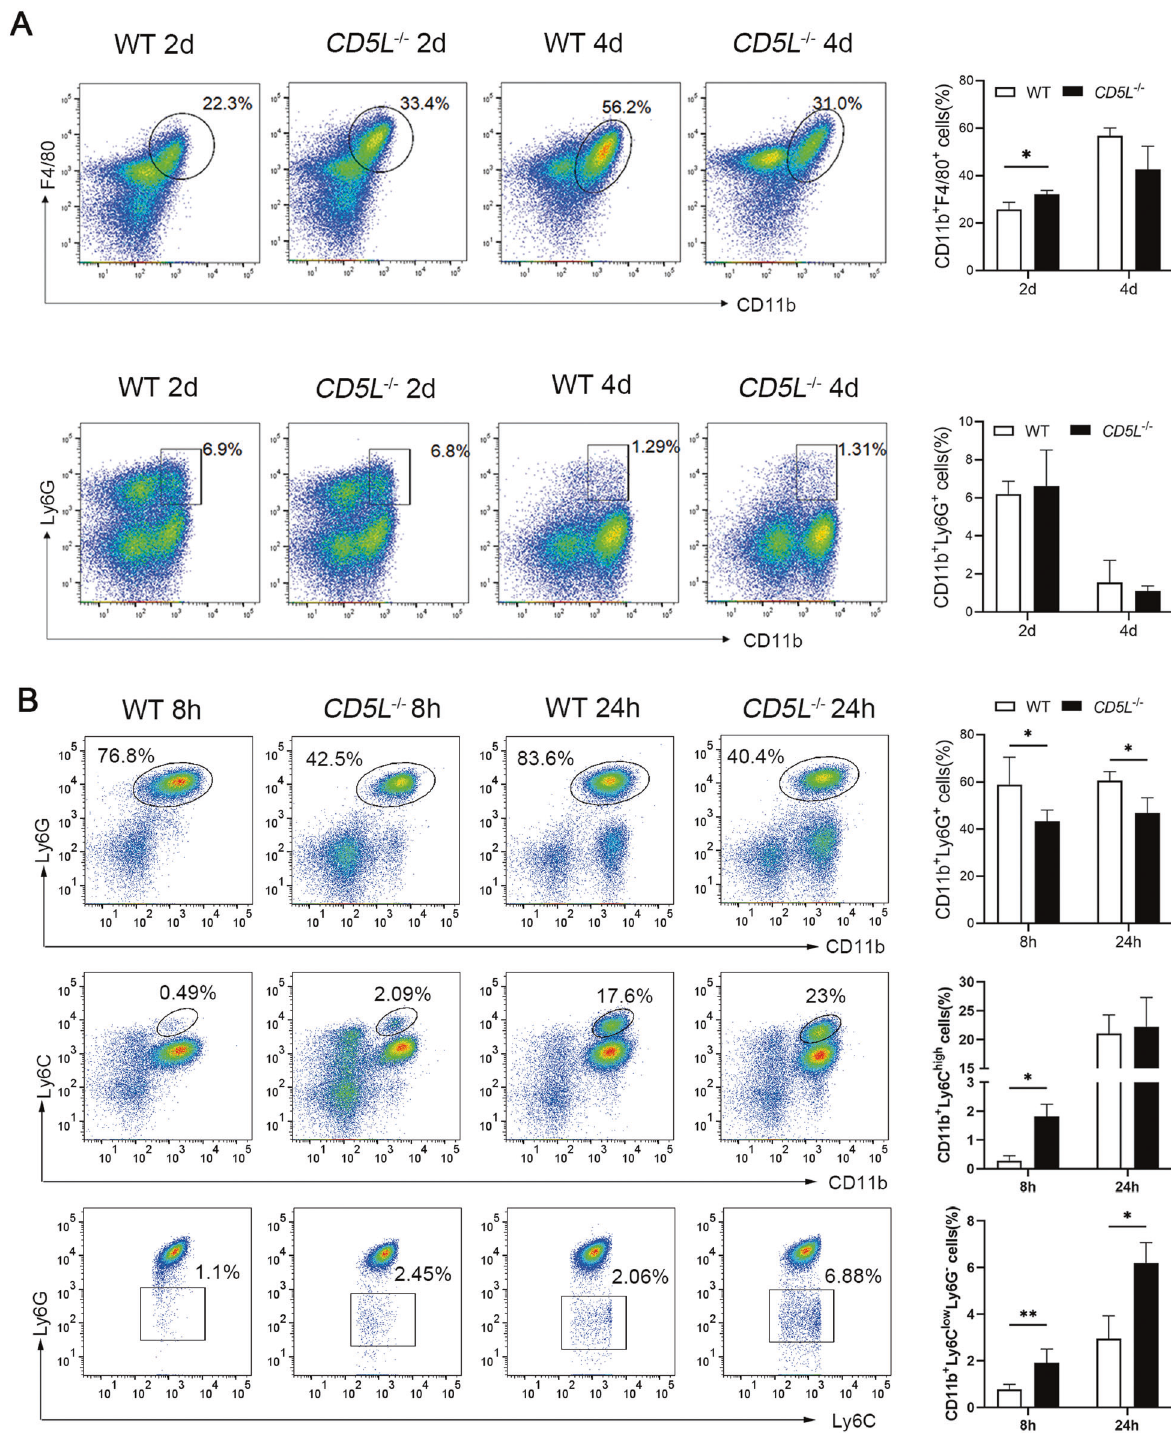
Fig. 5 CD5L changes the in fi ltration of neutrophils and monocytes in mice. A In fl ammatory cells isolated from mice at 2 and 4 days after intraperitoneal injection of 4% thioglycolate were analyzed by fl ow cytometry for macrophages (CD11b + F4/80 + ) and neutrophils (CD11b + Ly6G + ) ( n = 5 for each group at each time point); B Non parenchymal cells (NPCs) isolated from the liver of WT and CD5L − / − mice after APAP treatment for 8 h and 24 h ( n = 5 for each group at each time point) analyzed by fl ow cytometry. The expression of neutrophils (CD11b + Ly6G + ), CD11b + Ly6C high monocytes, and CD11b + Ly6C low monocytes (from top to bottom) after APAP treatment for 8 h and 24 h. The results are presented as means ± SD of at least three independent experiments. * P < 0.05; ** P <